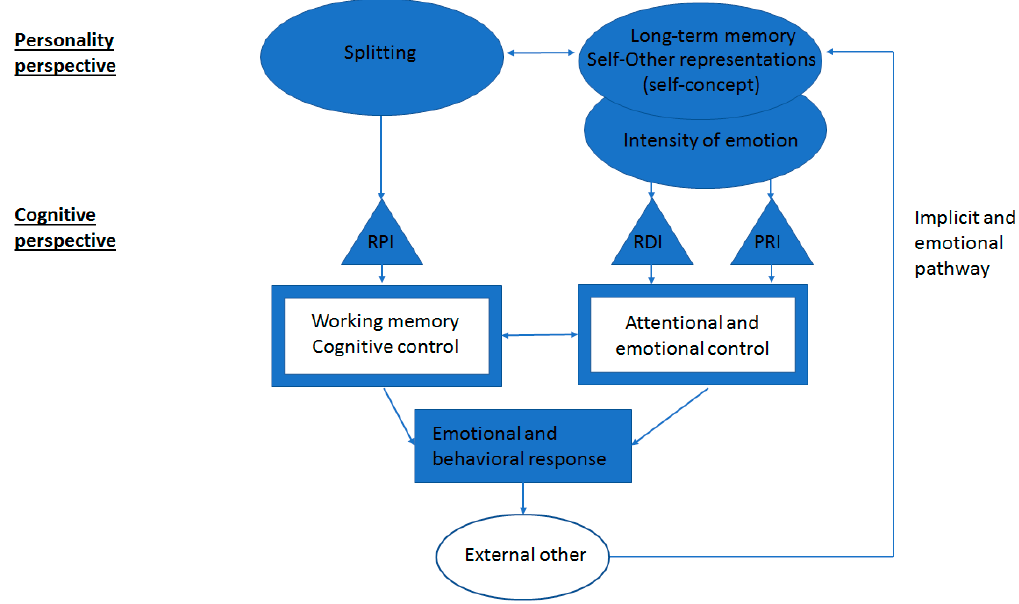
Figure 2. This model integrates the self-concept and inhibition processes in BPD. From the personality perspective, the self-concept, which belongs to long-term memory, is composed of self-representations and other-representations linked by an affect tone. The polarized positive or negative segments of self- and other-representations in BPD is associated with more intense and less nuanced emotions, which in turn interact with attentional and emotional control. The nonaffectively integrated BPD self-concept maintains a functional relationship with the use of splitting, which is a defense mechanism that separates negative self- and other-representations from positive self- and other-representations. The splitting belongs to working memory as a cognitive control process. From the cognitive perspective, each inhibition process plays a respective role in the regulation of cognitive, attentional and emotional control processes. In reaction to the individual’s impulsive and negative emotional and behavioral response, the other person’s (external other) negative response (i.e., social reject) reinforces the negative self-concept through implicit and emotional pathways of communication.